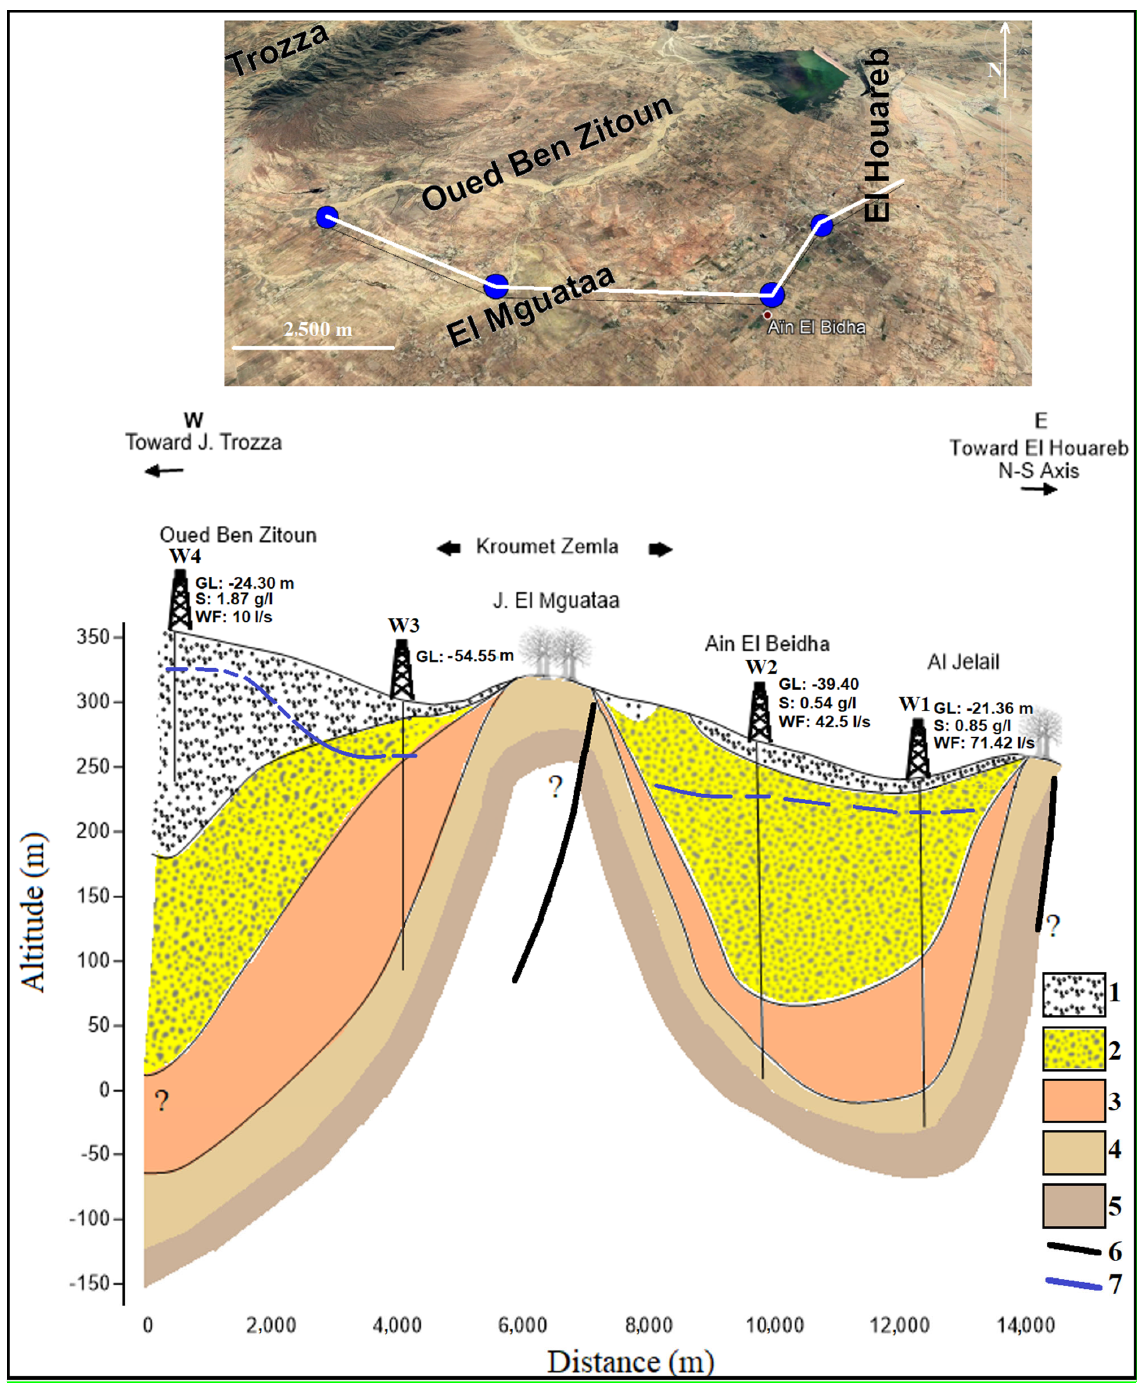
Figure 3. Hydrogeological wells correlation crossing the Ain El Beidha plain. (1) Quaternary and Mio–Plio–Quaternary. (2) Miocene (Ain El Beidha plain). (3) Oligocene. (4) Upper Eocene. (5) Lower Eocene. (6) Fault. (7) Water table level. GL: groundwater level. S: salinity. WF: water flow.